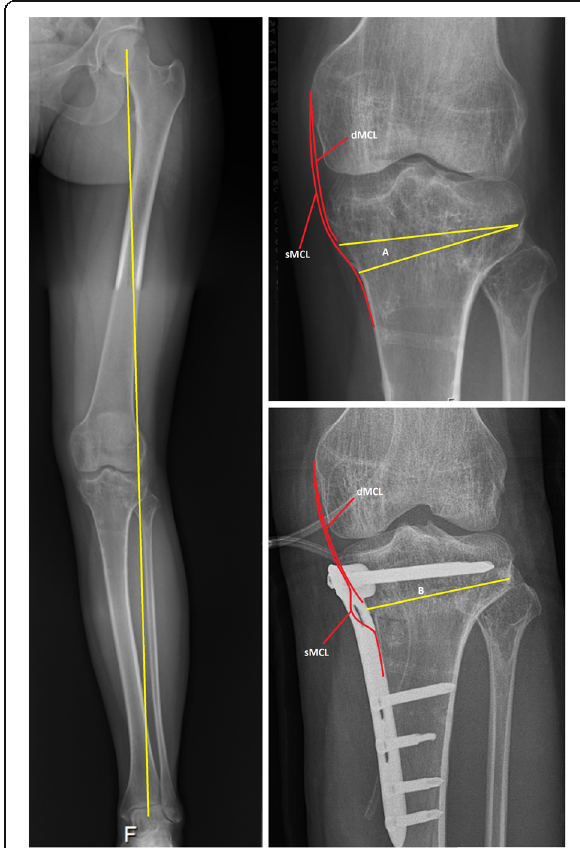
Fig. 1 Preoperative and postoperative radiographs of the osteotomy site in relation to the medial collateral ligament. Subscript: The left figure shows a pre-operative long-leg radiographs with valgus malalignment. The right figures show a preoperative (above) and postoperative (below) radiograph of the knee. The osteotomy site (A and B) is below the insertion of the deep medial collateral ligament (dMCL). In the postoperative situation a pseudo laxity of the superficial medial collateral ligament (sMCL) is